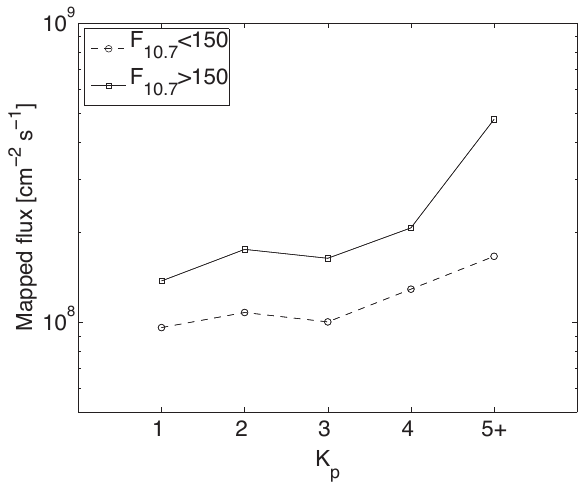
Fig. 10. Magnetic activity dependence. The mapped ionospheric flux as a function of K p